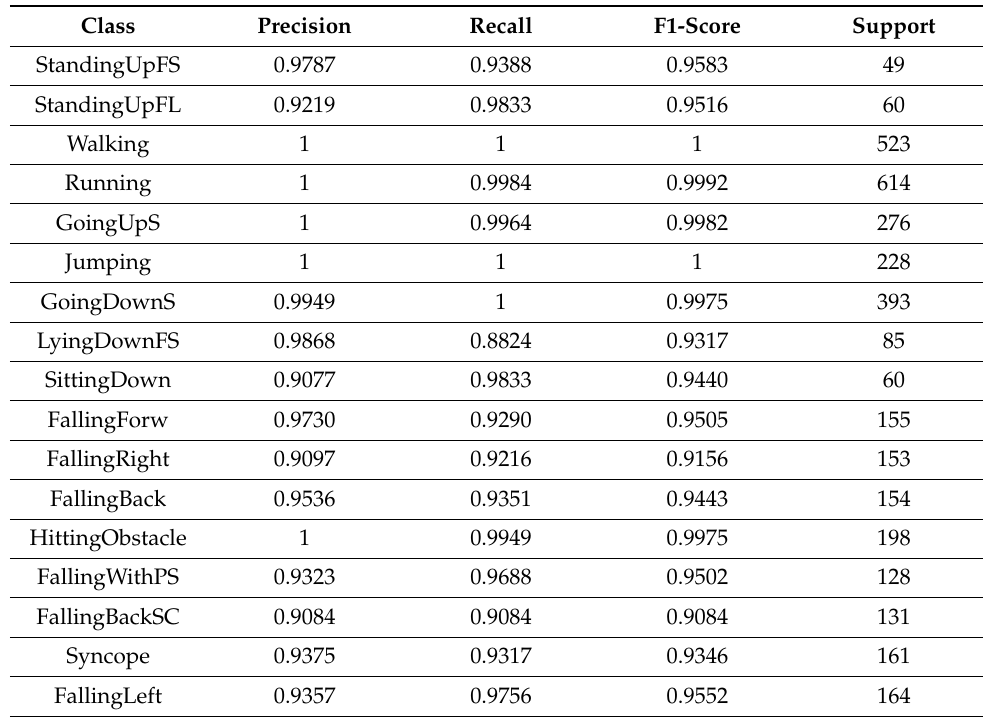
Table A2. CNN2—Subject-dependent detailed performance macro